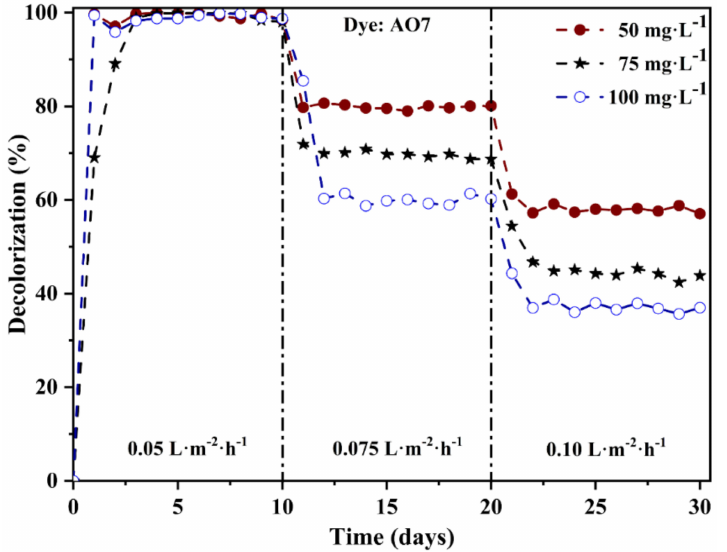
Figure 7. Decolorization of AO7 at different permeate flux and feed concentrations. CSCM: 10%